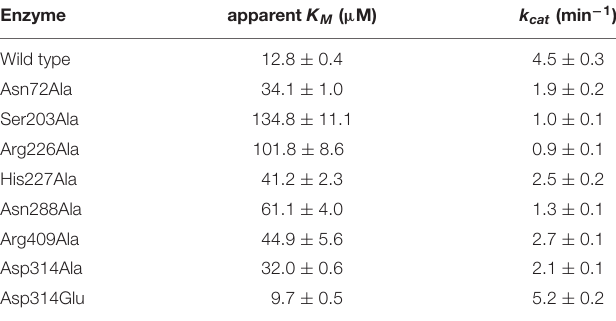
TABLE 3 | Kinetic parameters for Tmm 7211 and its mutants toward NADPH. Enzyme apparent K M ( µ M)